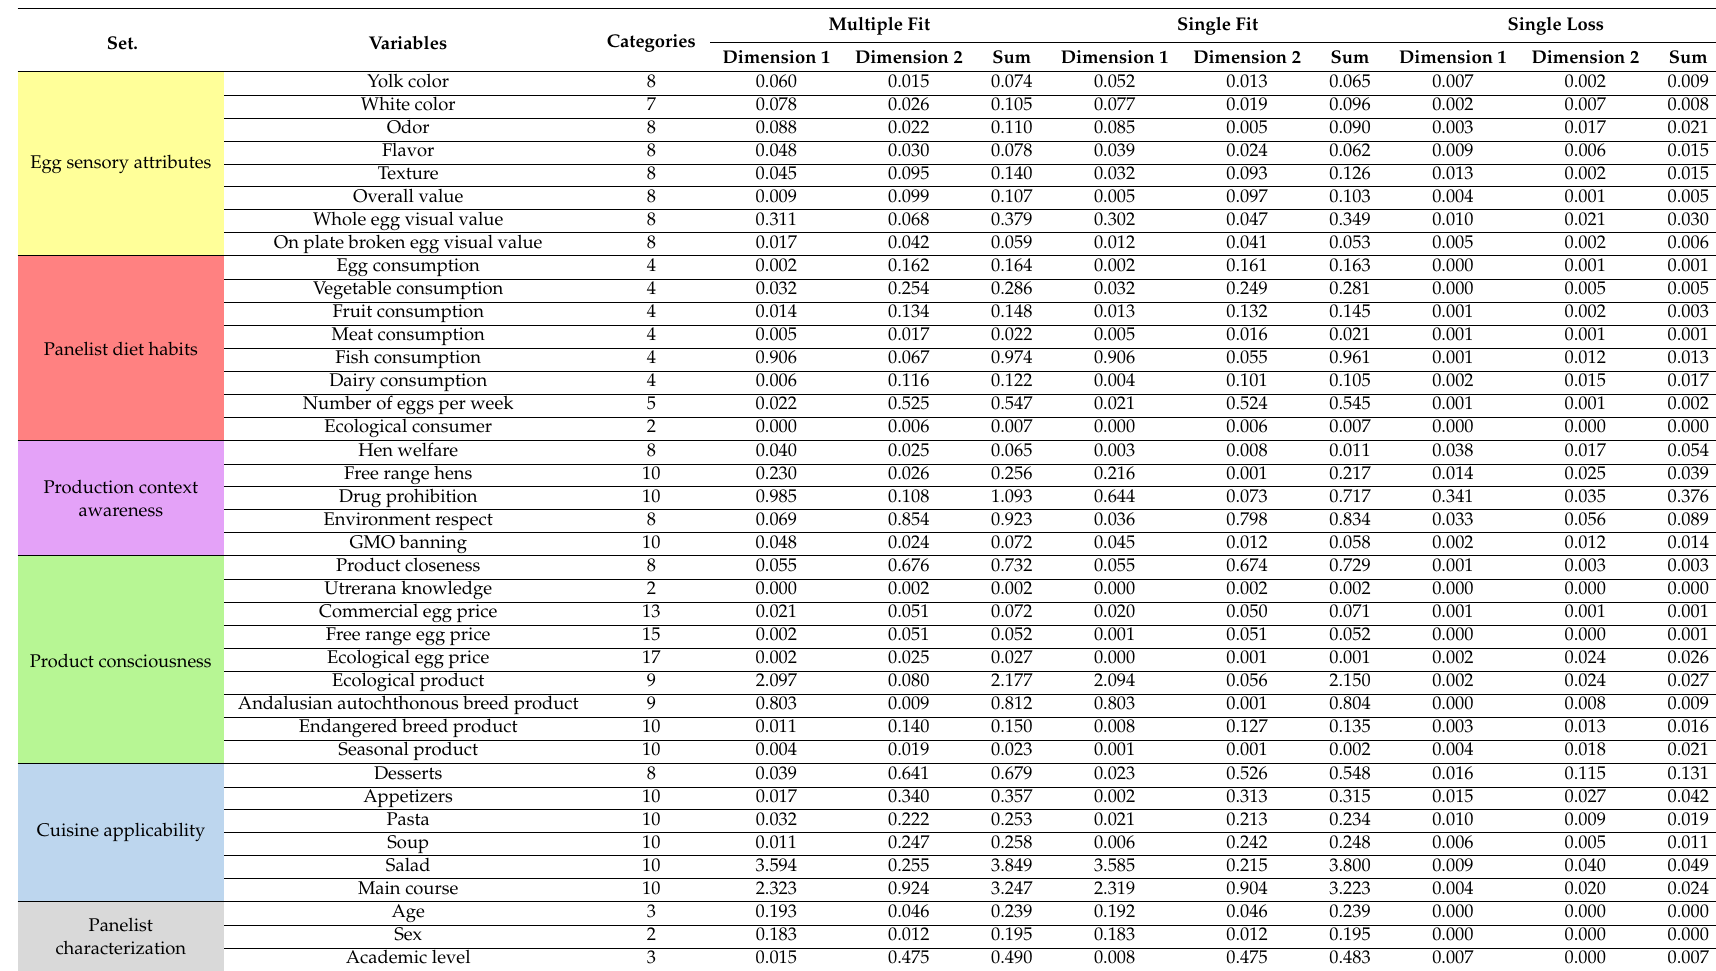
Table 3. Model partitioning fit and loss analysis for Utrerana native hen egg sensory attributes (yellow), panelist diet habits (red), production context awareness (purple), product consciousness (green), cuisine applicability (blue) and panelist characterization (grey) as perceived by cuisine instructed panelists (n = 192).